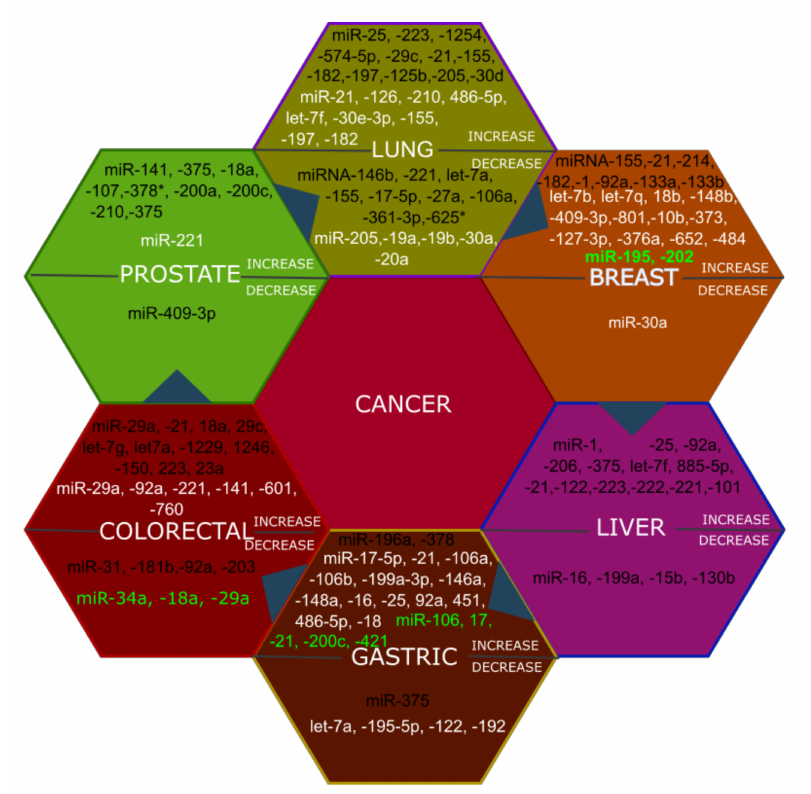
Figure 2. Summary of modulated circulating microRNAs in several prominent cancer types including breast cancer, lung cancer, prostate cancer, colorectal cancer, liver cancer. Circulating miRNAs were from serum (black), plasma (white), and blood (green) of both cancers diagnosed and control counterparts with their levels (either increase or decrease)